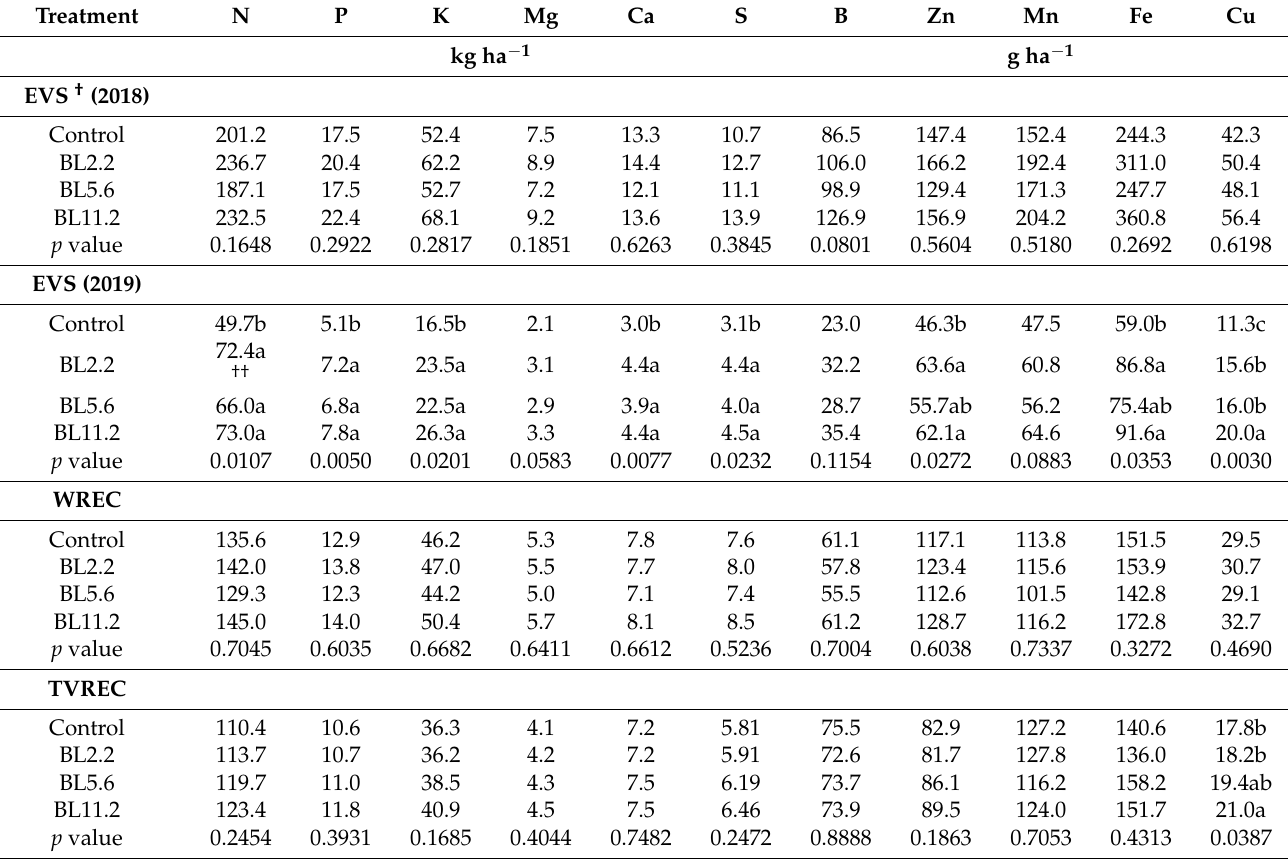
Table 5. Seed nutrient uptake of soybean fertilized with broiler litter (BL) at the experimental sites.